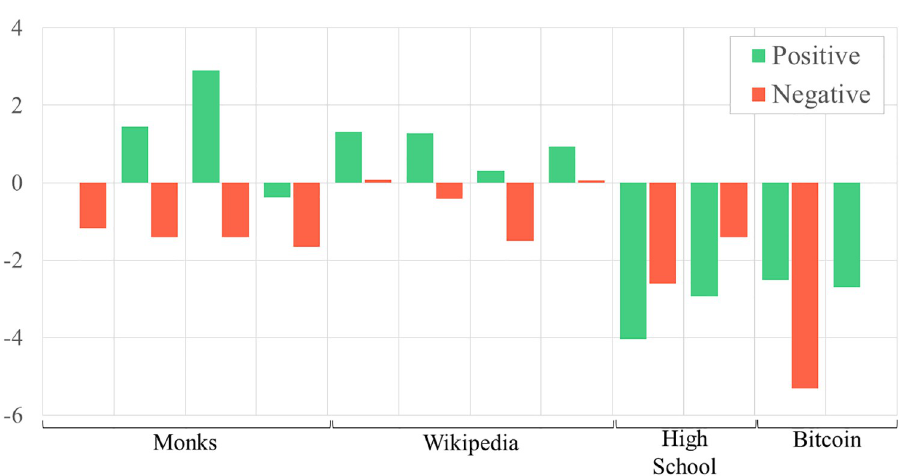
Fig 4. Outdegree skew ERGM coefficient values for positive versus negative networks grouped by network type.